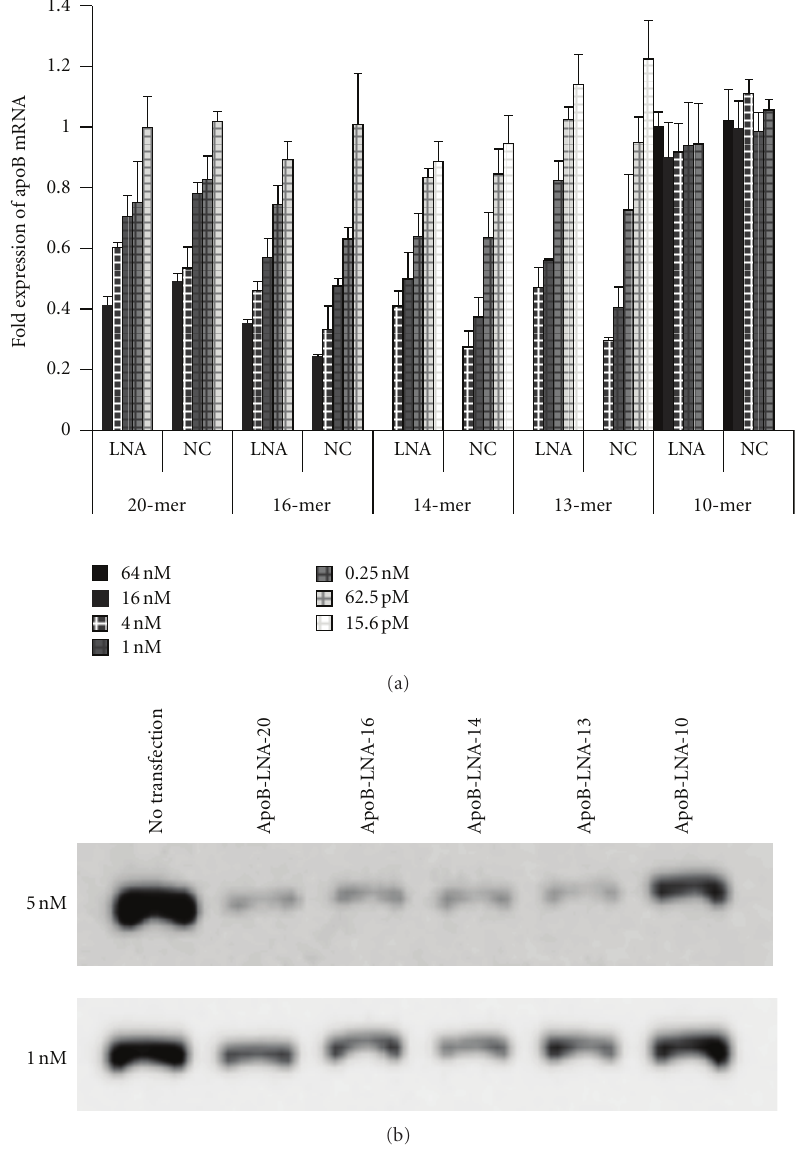
Figure 2: In vitro silencing properties of BNA-based AONs. (a) Various concentrations (15.6pM–64nM) of AONs were introduced into Huh-7 cells using Lipofectamine 2000. After 24-h incubation, the cells were collected, and the expression levels of apoB mRNA were determined. Data represent means ± SD. (b) Reduction of Apo B protein levels in the culture medium following transfection was confirmed by western